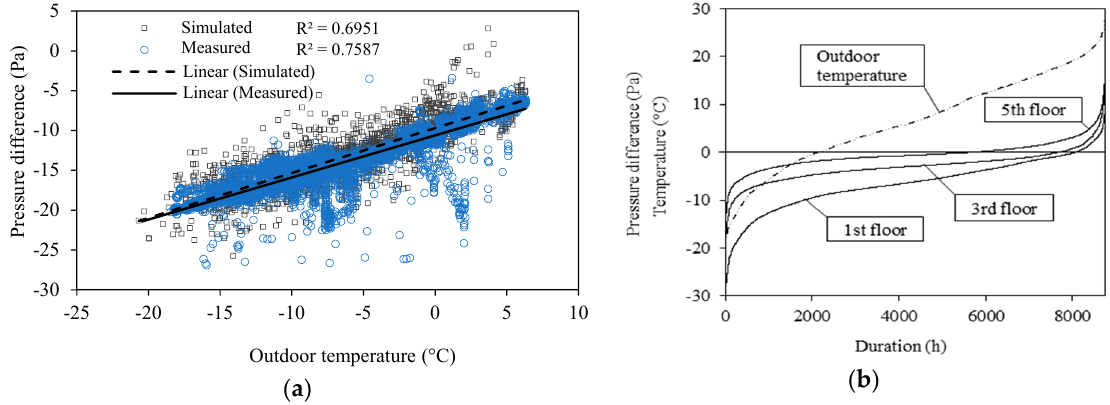
Figure 12. ( a ) Dependence between measured and simulated indoor and outdoor pressure di ff erences on the indoor–outdoor temperature di ff erence in the first-floor apartment. ( b ) The outdoor temperature and simulated whole-year pressure di ff erence in the top, middle and bottom floor apartments of the 5-story apartment building.